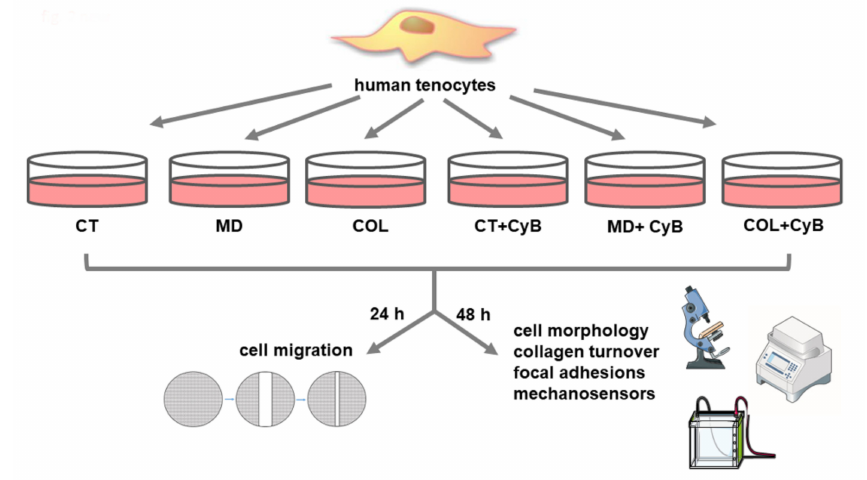
Figure 2. Diagram summarizing the experimental groups and the experimental design used in this